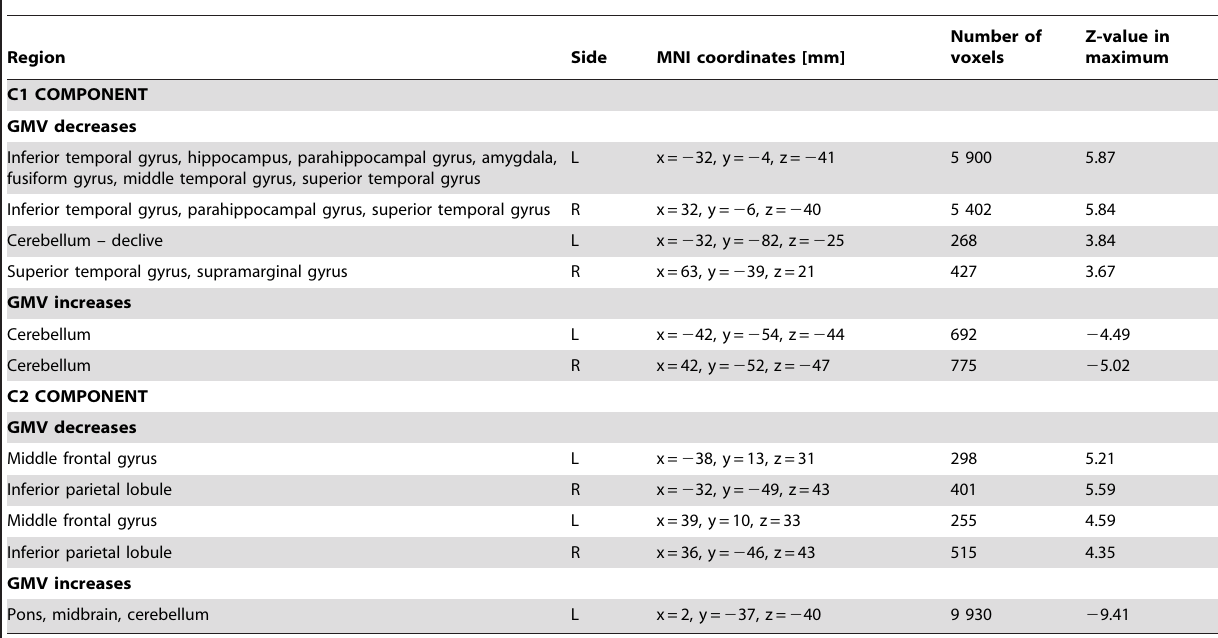
Table 3. Patterns of GMV